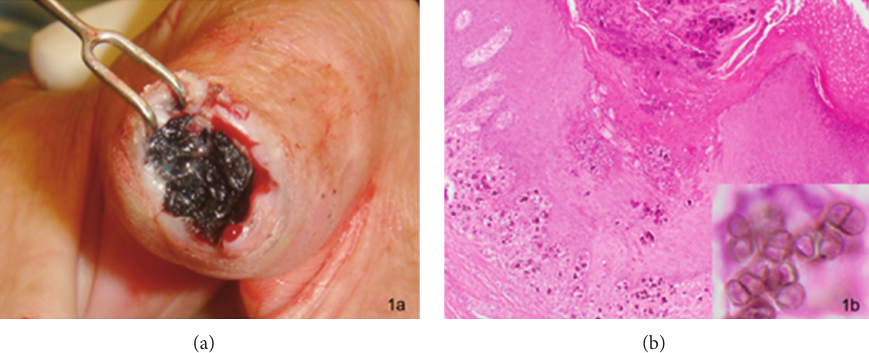
Figure 1: (a) Black pigmented cauliflower-like skin tumor on the amputation stump of the left index finger. (b) Pseudoepitheliomatous hyperplasia and chronic inflammation of the cutaneous, subcutaneous, and osseous tissues (overview) caused by the pigmented fungal elements of chromoblastomycosis (magnification) (hematoxylin and eosin